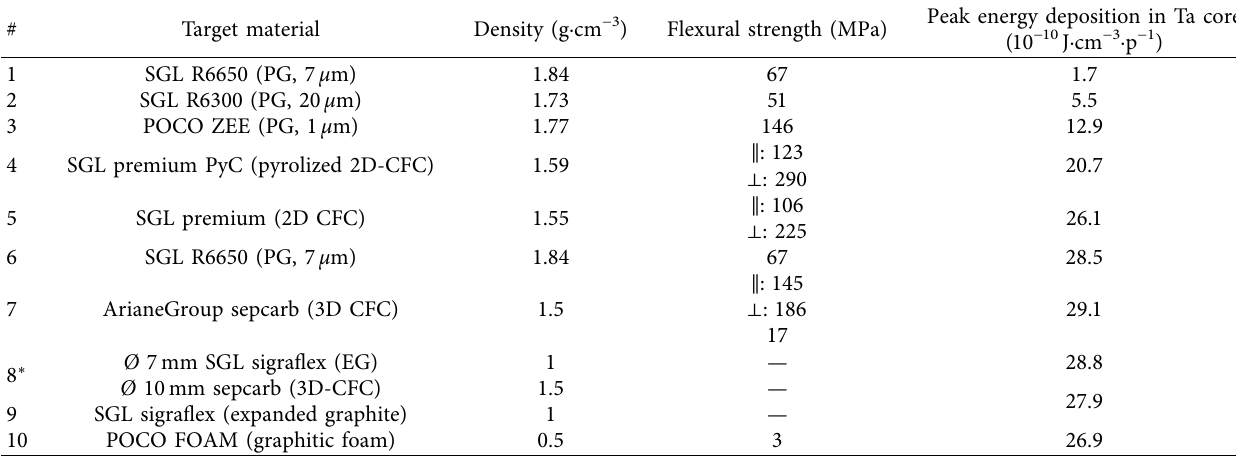
Table 1: Overview of target materials. The first column denotes the position of the target along the beam direction (cf. Figure 2(b)). In the second column, μ m values for polycrystalline graphites (PG) denote the particle size according to the manufacturer. The flexural strength is determined in three-point bending geometry. ‖ / ⊥ denotes the respective flexural strength parallel and perpendicular to the fiber-rein- forcement plane of carbon fiber reinforced graphite (CFC). The third value for #7 Sepcarb indicates the tensile strength of its graphite matrix. Peak energy deposition values are calculated using FLUKA and represent the peak transversal energy deposition density per primary 440GeV proton in the tantalum core averaged over the sample length (cf. Figure